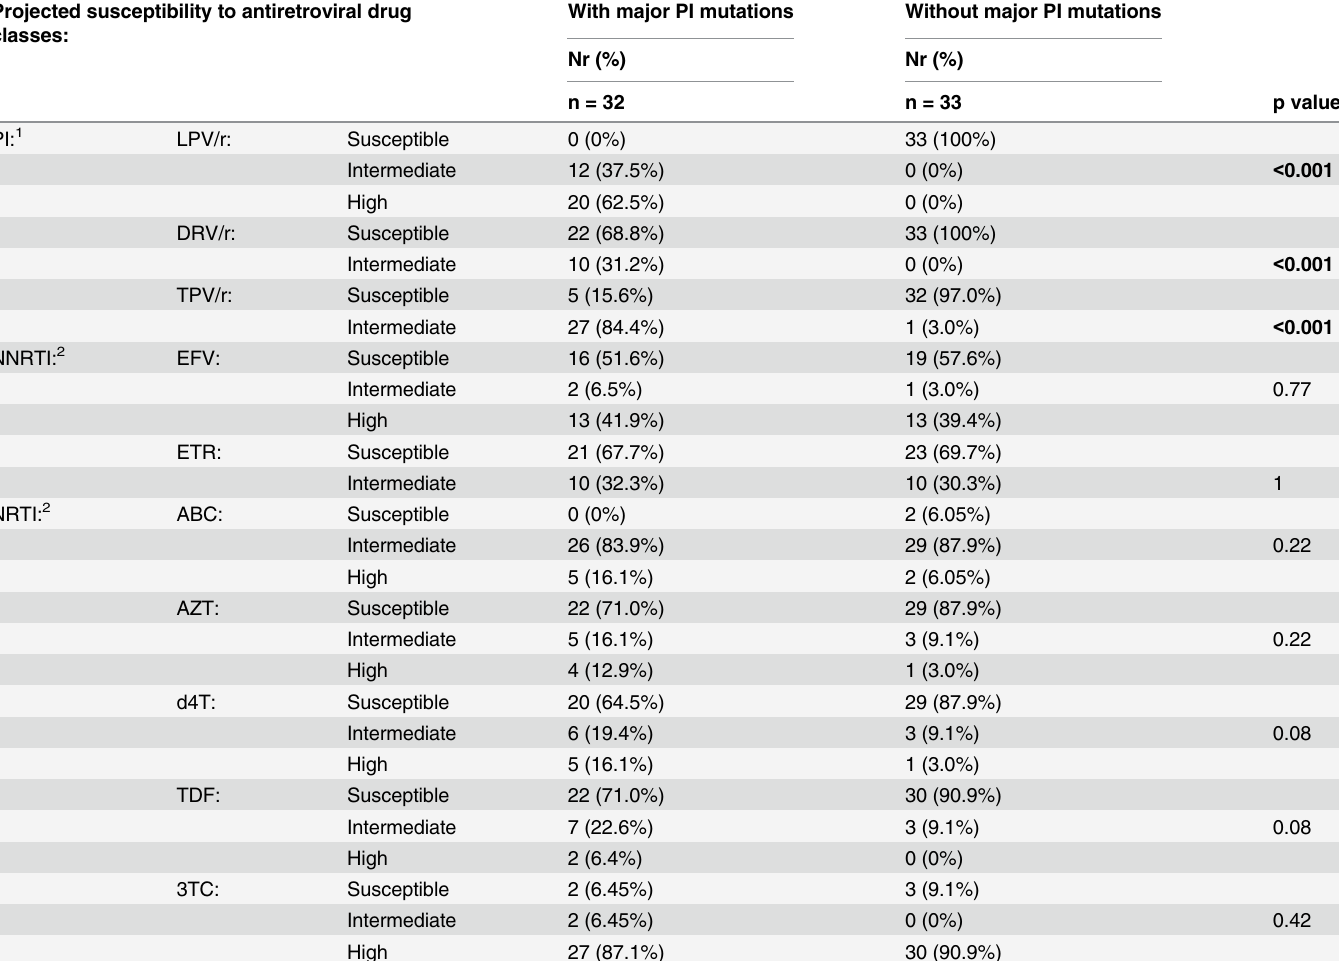
With major PI mutations Without major PI